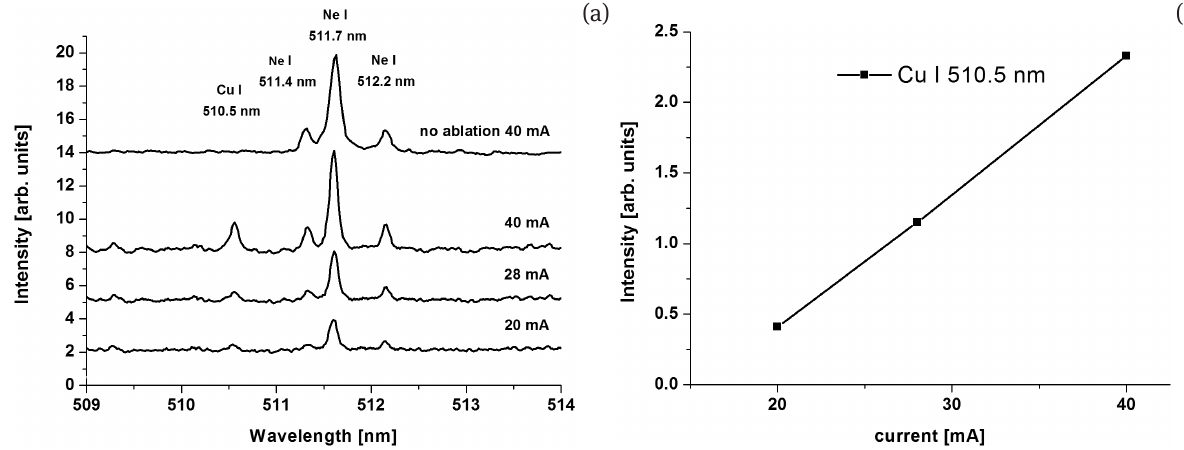
Figure 4 : Intensity of Cu I 510.5 nm spectral line from LIP-HCD as a function of buffer gas pressure at 40 mA discharge current.